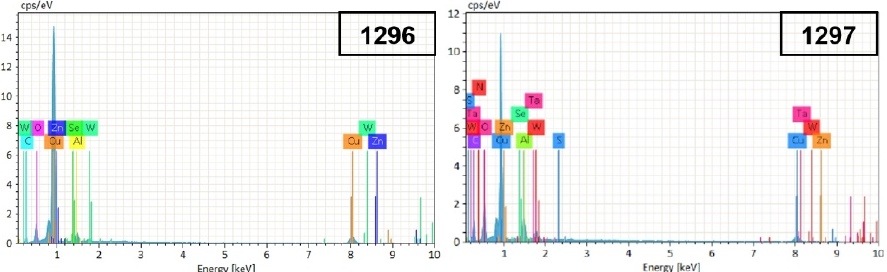
Figure 13. Points analyzed in scanning electron microscope in the mobile contact of Figure 12a.